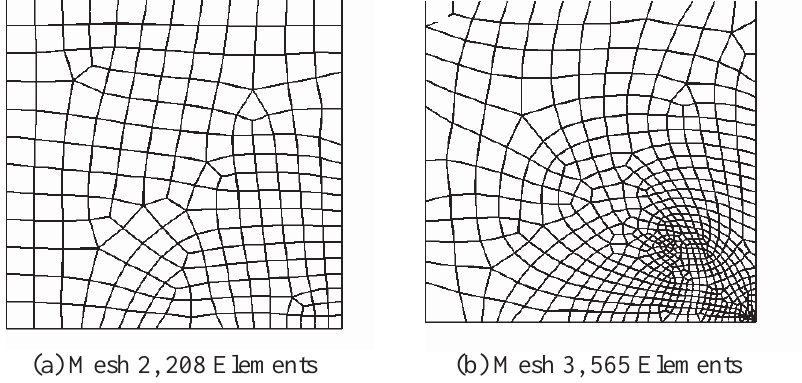
Fig. 6. Symmetric quadrant of a clamped square composite plate subjected to impact by a sphere at the center of the plate.